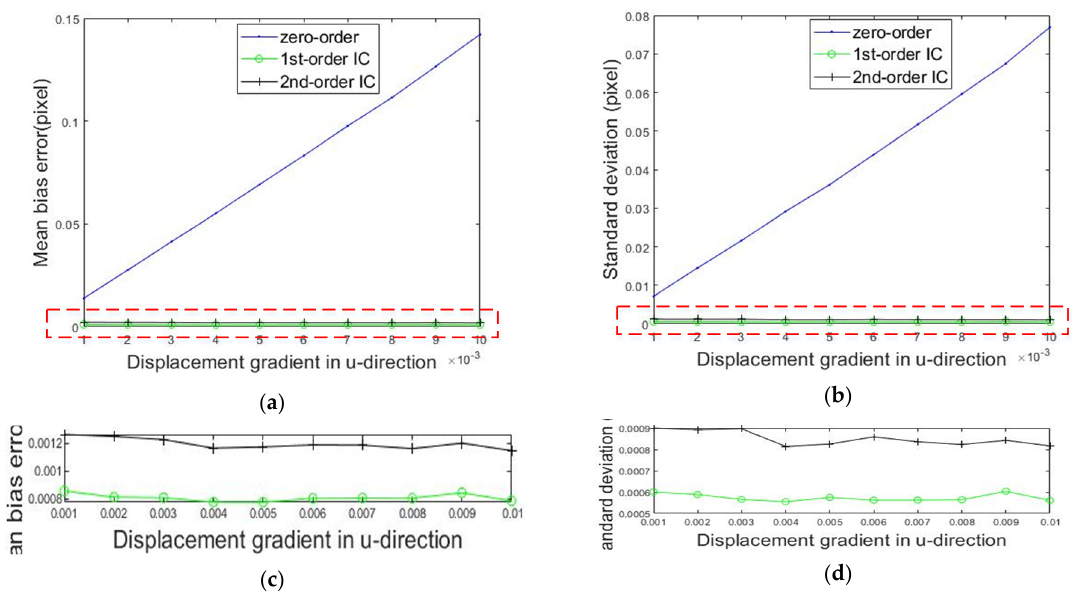
Figure 9. Calculated errors of the uniform deformations compared to the set values. ( a ) Mean bias error; ( b ) standard deviation; and ( c,d ) enlarged views of the red dotted areas in ( a ) and ( b ), respectively.